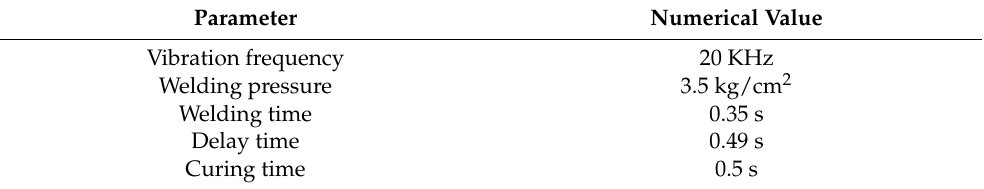
Table 4. Ultrasonic process